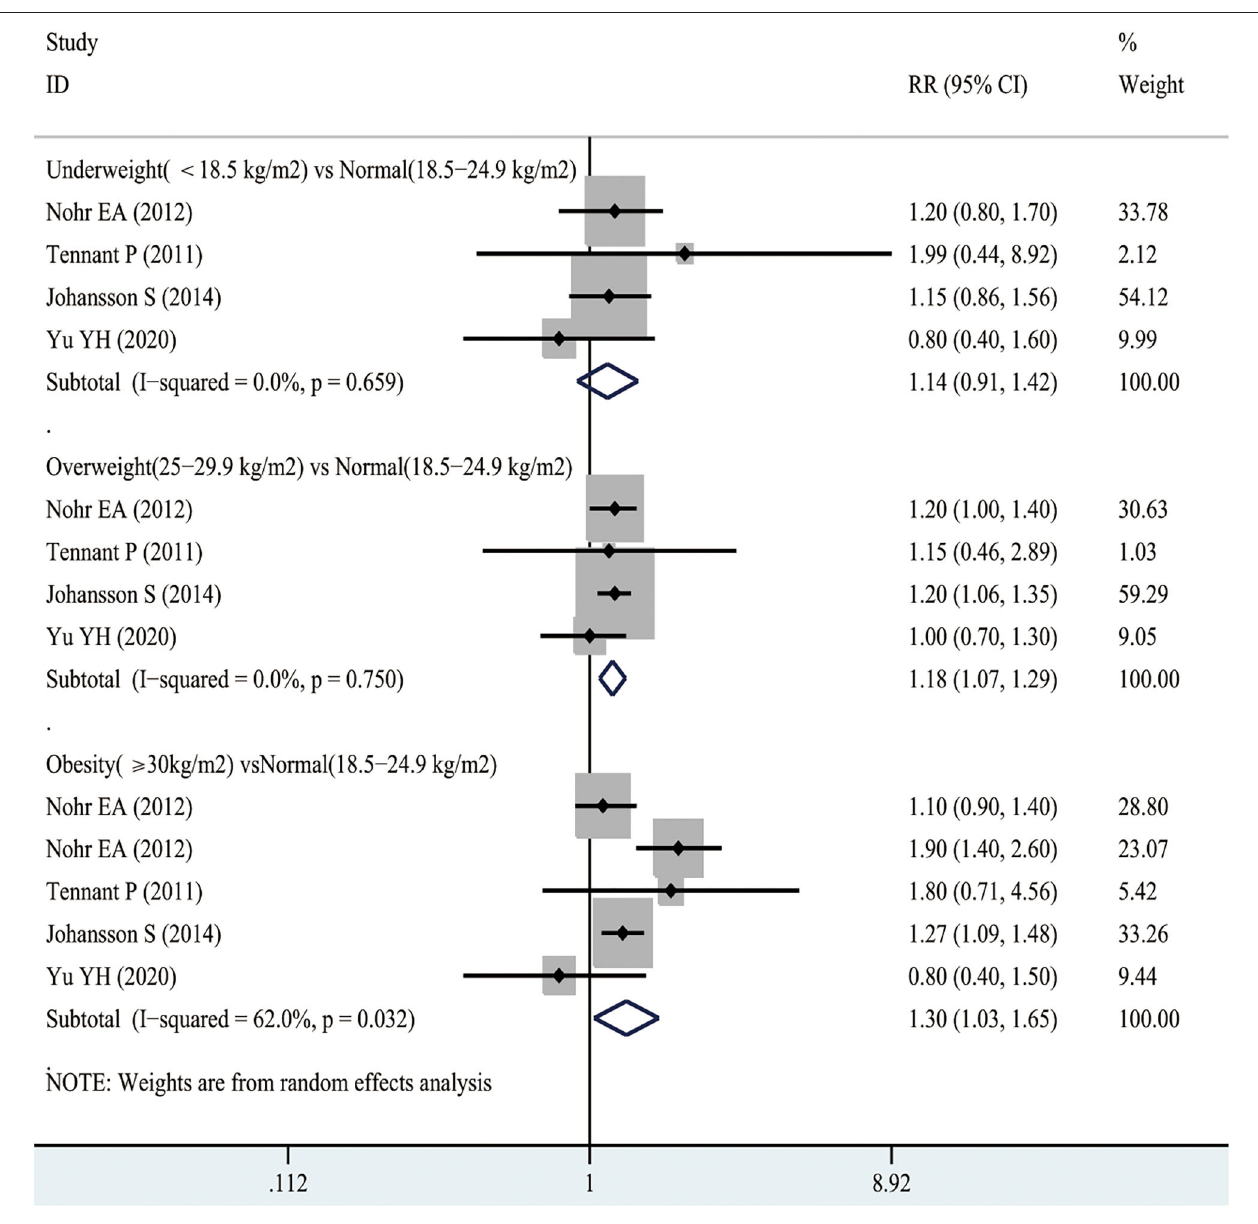
FIGURE 5 | Forest plots of maternal BMI and the risk of post-neonatal